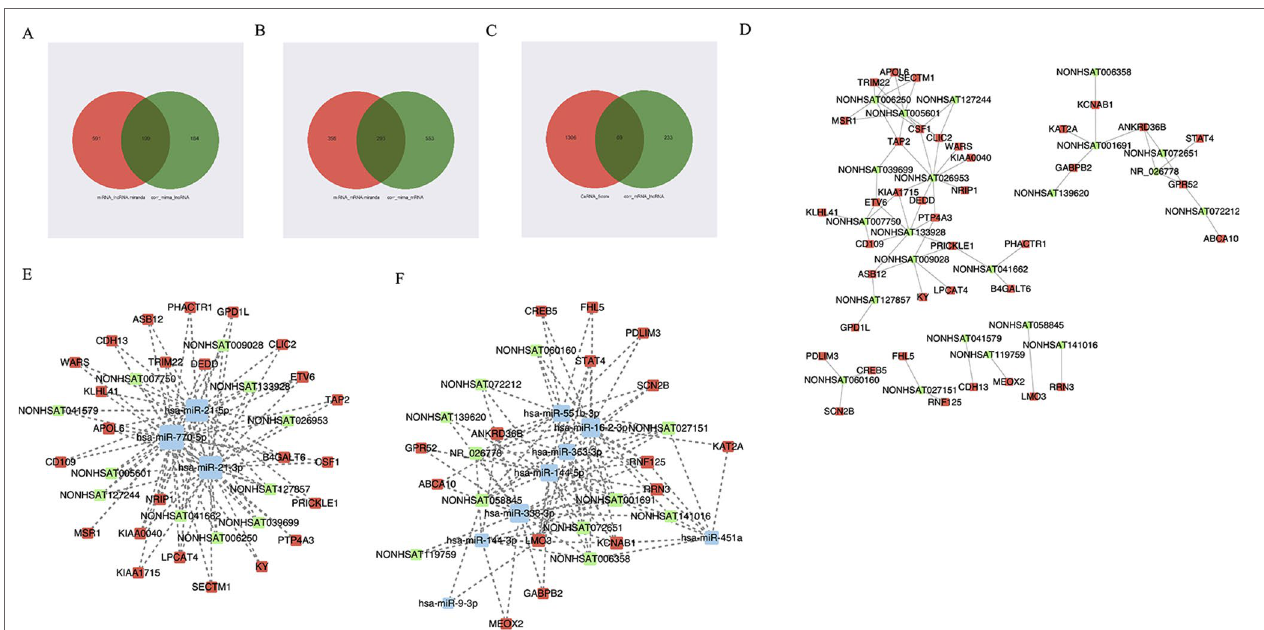
FIgURE 3 | The view of lncRNA-miRNA-mRNA network. (A–C) 199 miRNA-lncRNA pairs and 293 miRNA-mRNA pairs were identified according to both base sequence and expression level. 69 lncRNA-mRNA pairs were selected according to the ceRNA score and expression level. (D) The view of lncRNA-mRNA network. The square represents mRNA and the circle represents lncRNA. (E, F) The view of lncRNA-miRNA-mRNA network. The red represents mRNA, the green represents lncRNA, and the blue represents miRNA.